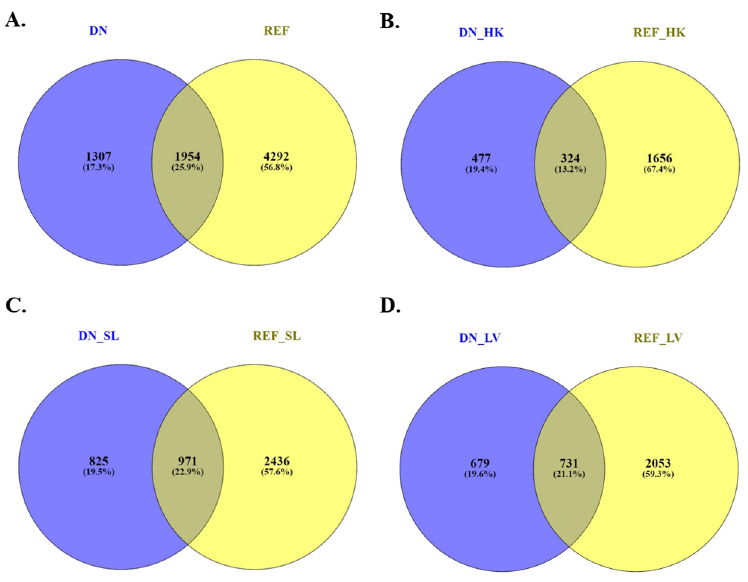
Figure 5. Comparison of DEGs identified by reference genome-guided and de novo transcrip- tome assembly. ( A ). Comparison of DEGs identified by reference genome-guided and de novo transcriptome assembly; ( B ). Comparison of DEGs identified by reference genome-guided and de novo transcriptome assembly in the head-kidney; ( C ). Comparison of DEGs identified by reference genome-guided and de novo transcriptome assembly in the spleen; ( D ). Comparison of DEGs iden- tified by reference genome-guided and de novo transcriptome assembly in the liver; REF: reference genome-guided transcriptome assembly. DN: de novo transcriptome assembly. HK: Head-kidney. SL: Spleen. LV: Liver. DEGs: differentially expressed genes. Filtration of DEGs is log 2 FC ≥ 1, FDR ≤ 0.05.